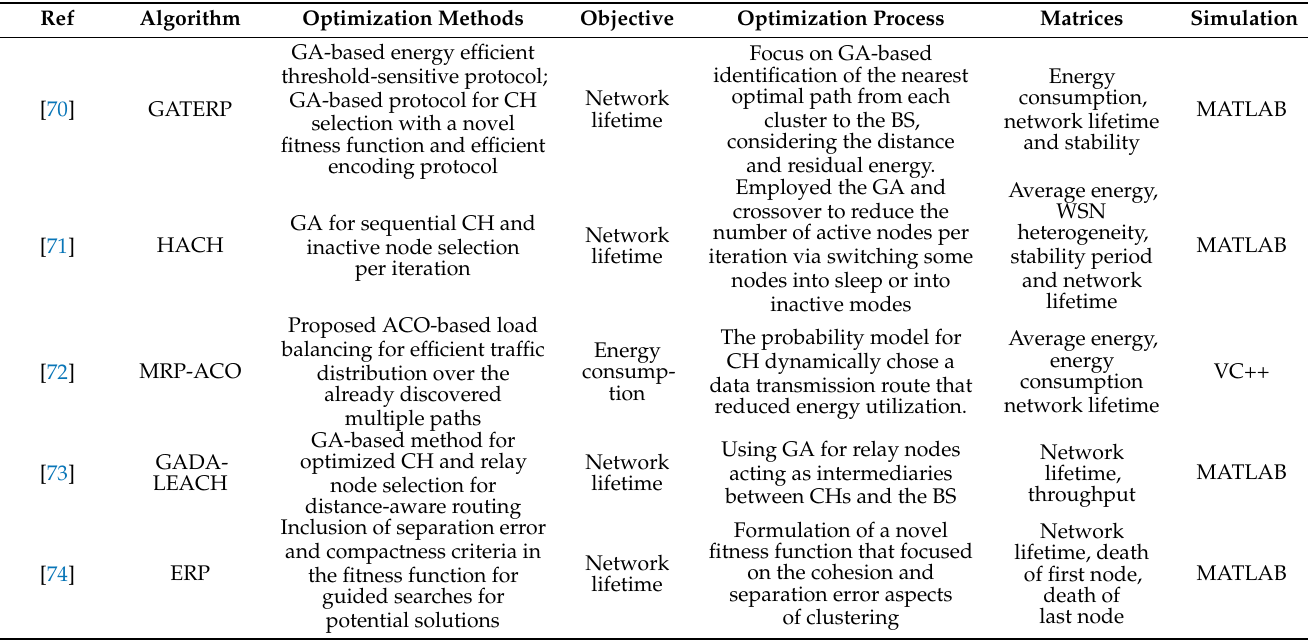
Table 3. Comparison of studies Evolutionary